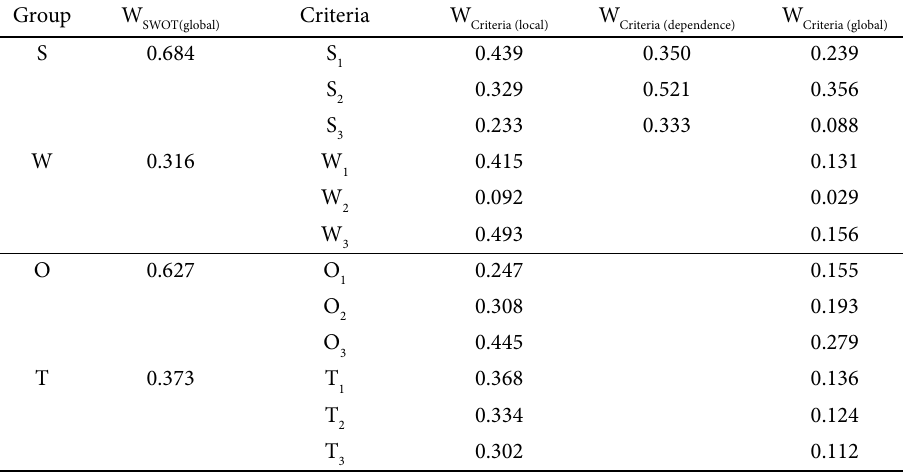
Table 11. The computed results for all